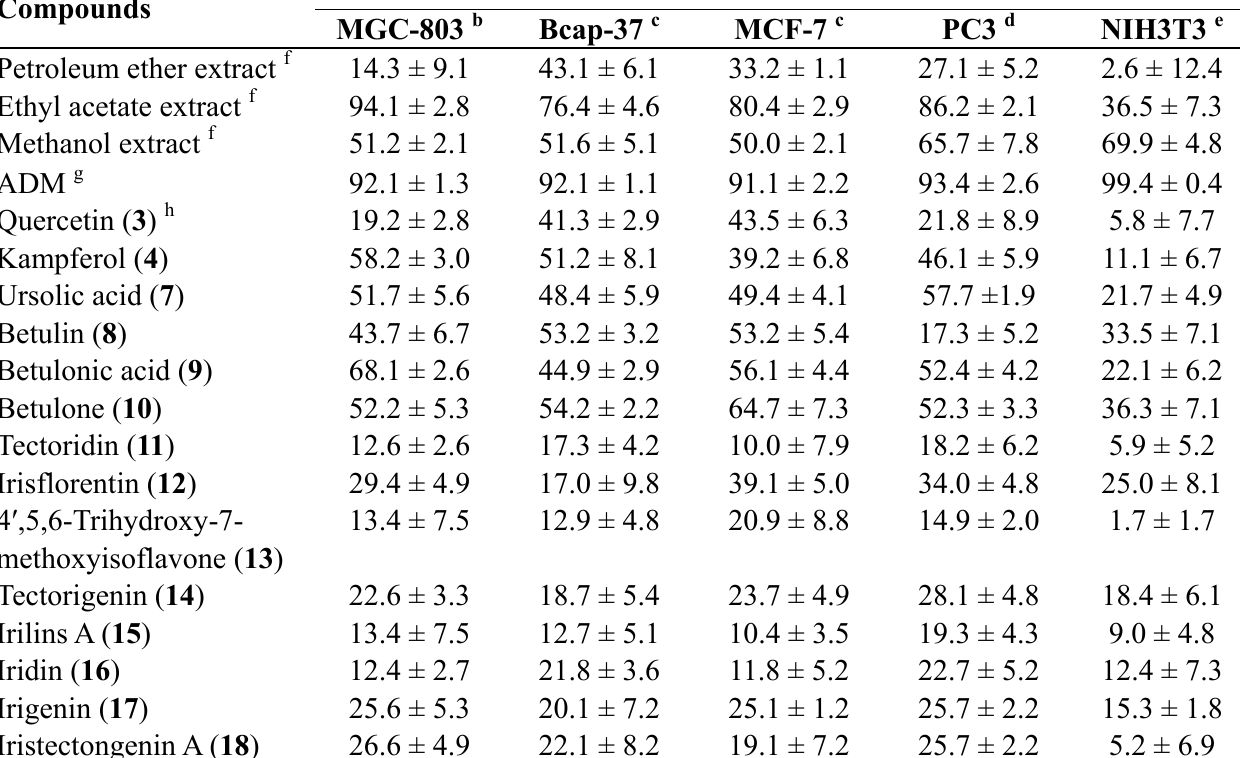
Table 1. Antitumor activities of the extracts and isolated compounds on the proliferation of different cancer cell